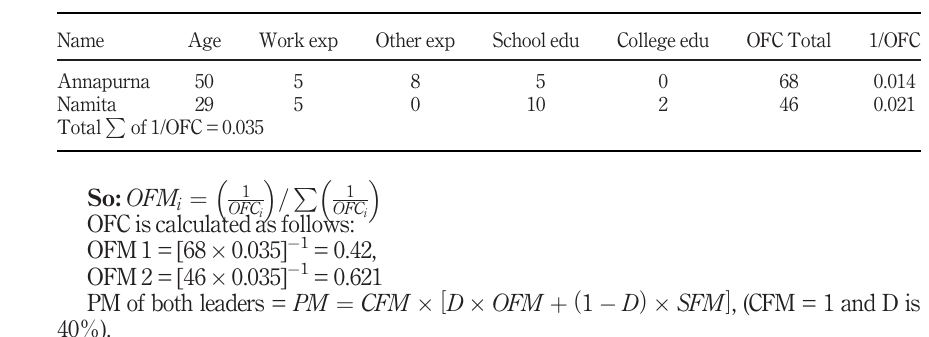
Table 11 Performance Measure calculation of both